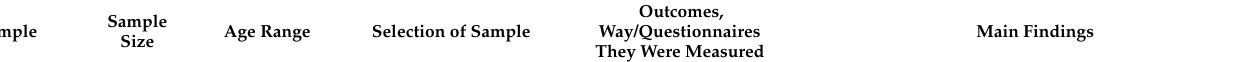
(KIDMED) questionnaire, lifestyle questionnaires during